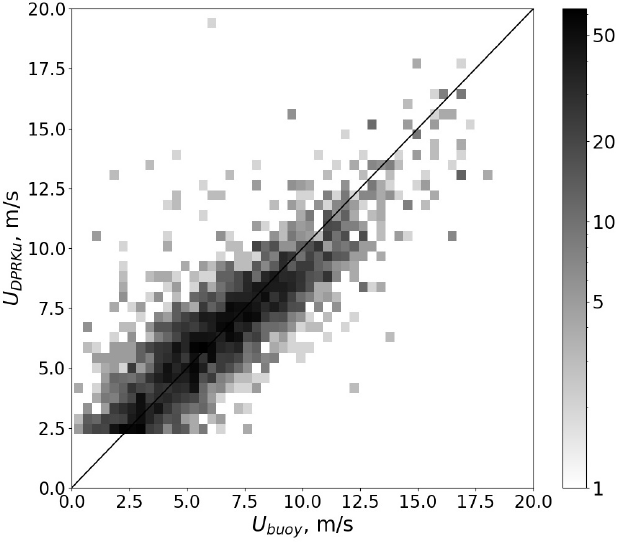
Figure 5. Global comparison between Ku-band radar and buoy wind speed values during the period